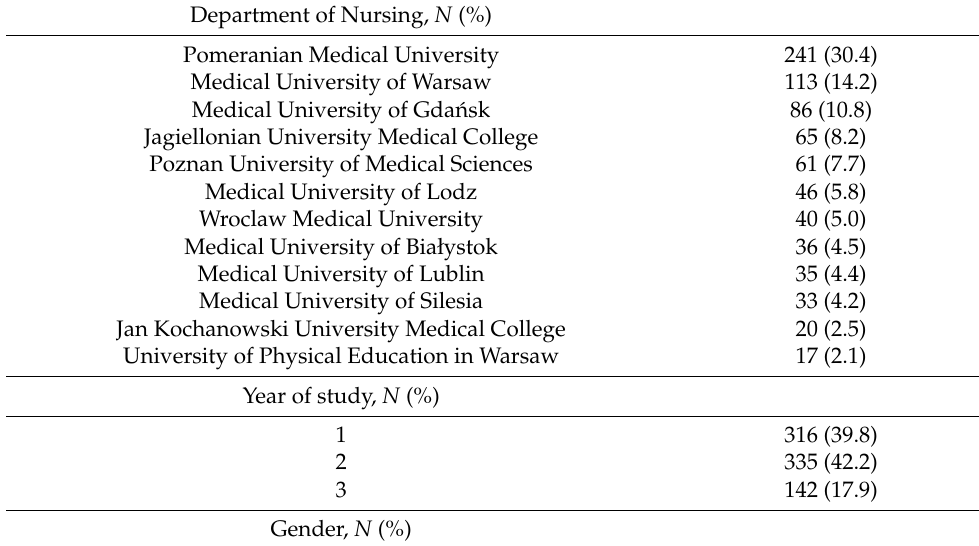
Table 1. Characteristics of the study group ( N =